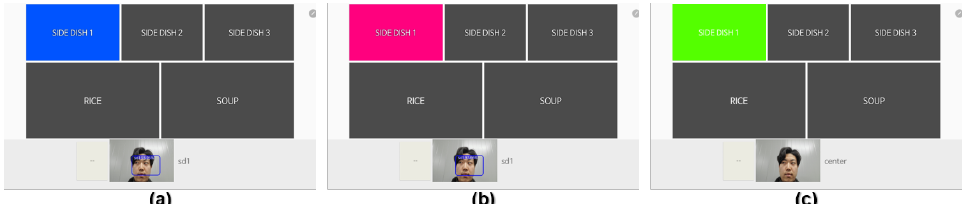
Figure 12. Tablet UI screens showing each step of face recognition. ( a ) A screen of food selection stage 1. This shows the real-time recognition result before entering food selection stage 2. The detected food is highlighted in blue. ( b ) Upon entering food selection stage 2, the result turns red. ( c ) The state in which the choice in food selection step 2 is finally confirmed. The food is highlighted in green, and the corresponding command is sent to the robot